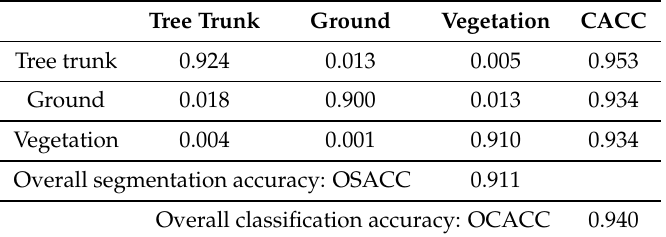
Table 2. Segmentation and classification results for Urban Data Challenge data set (Data_set-1).